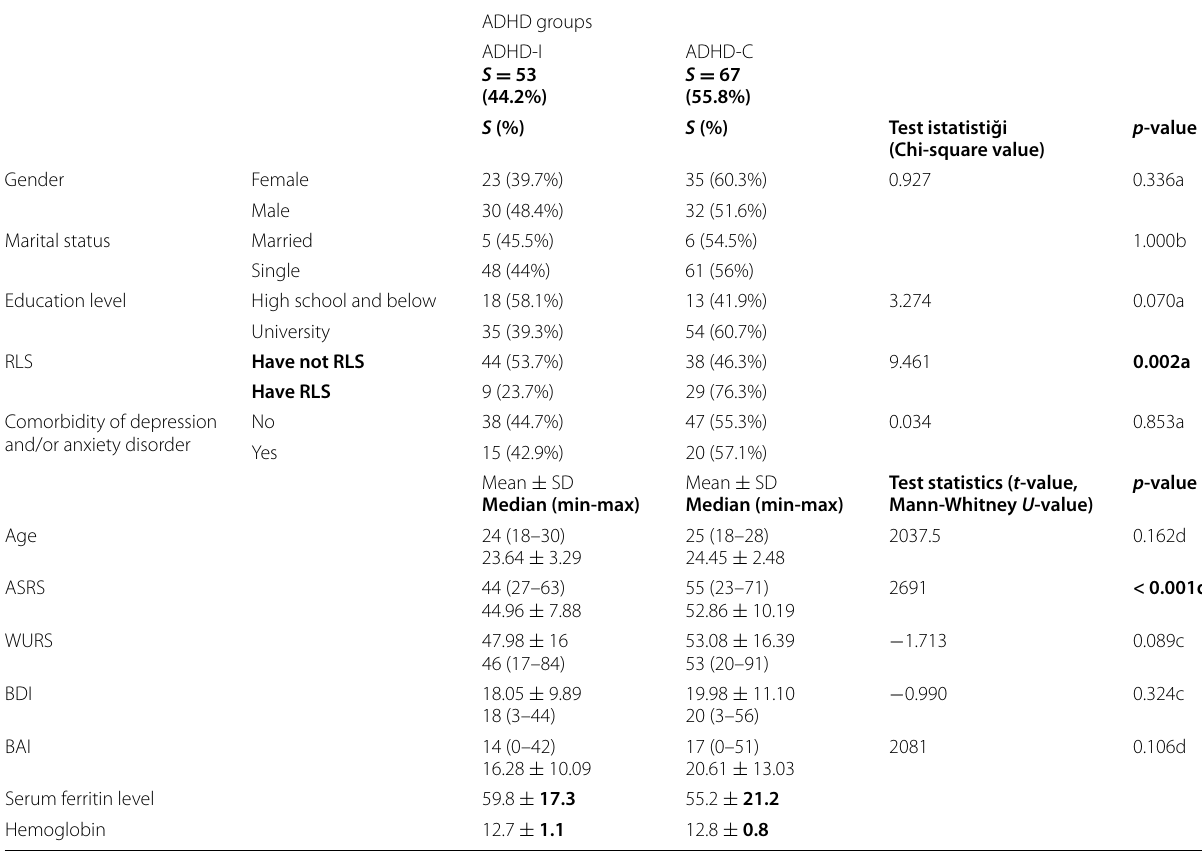
Table 1 Comparison of demographic characteristics, RLS,comorbidity, ASRS, WURS, BDI, and BAI scale scores between ADHD